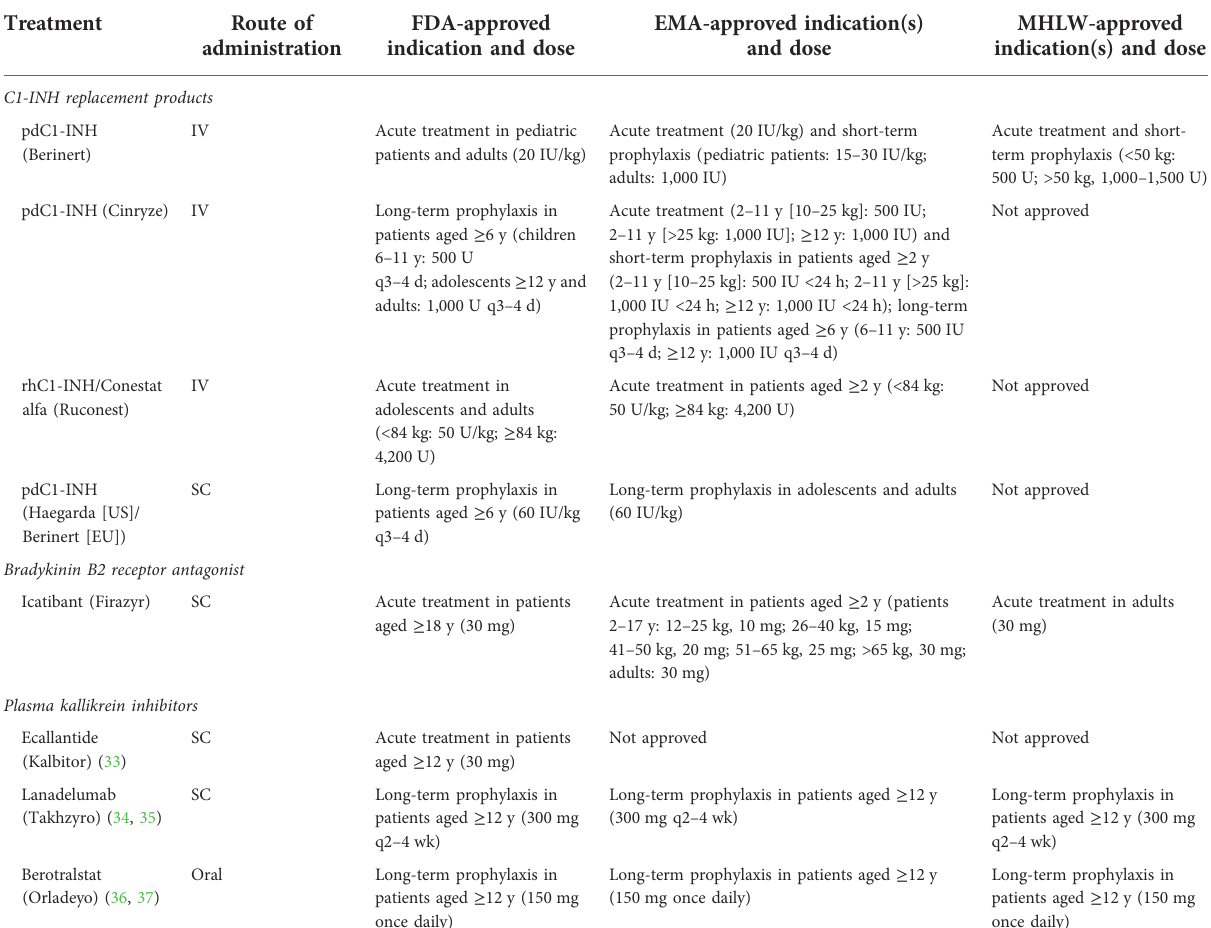
TABLE 1 Approved treatments for hereditary angioedema. Treatment Route of